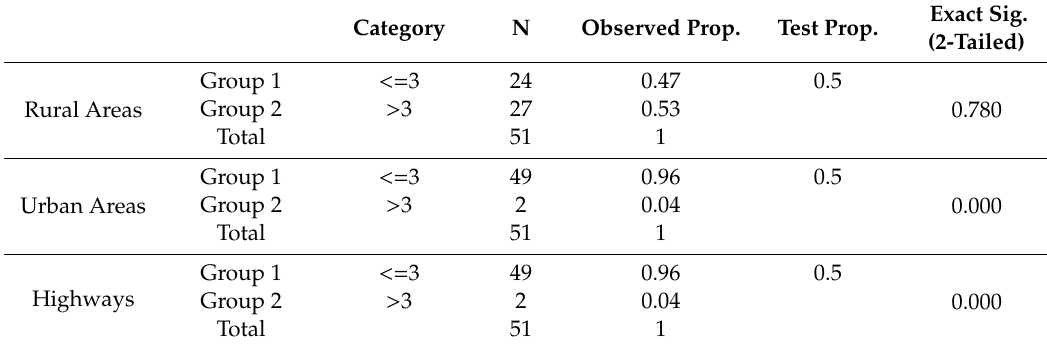
Table 8. Binomial test (Statistics) for connected vehicles.